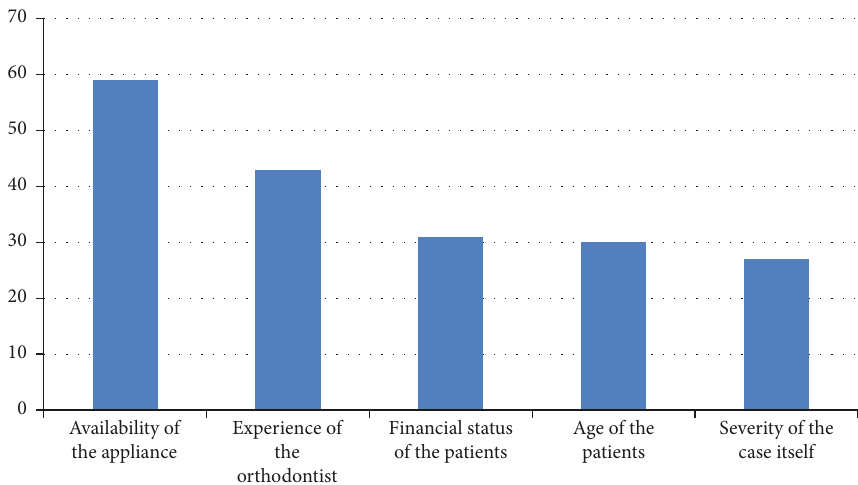
Figure 2: Factors limiting orthodontists’ choice for the fixed functional